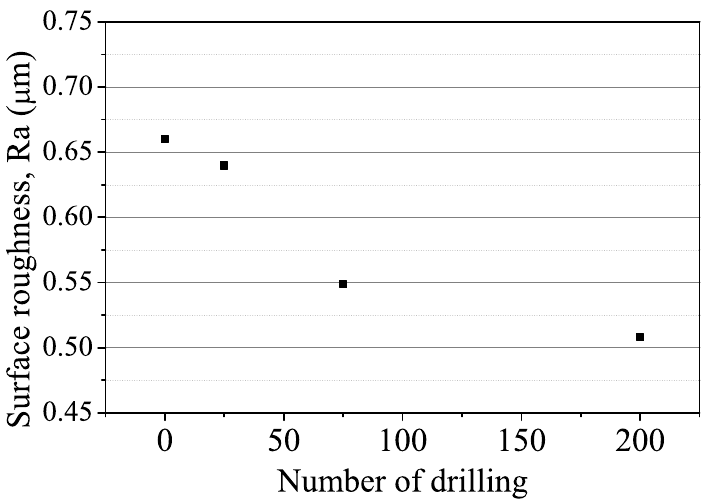
Figure 12. Surface roughnesses of tools according to the numbers of drilling (drilling conditions: axial feedrate 10 µ m/s; rotational speed pf 50,000 rpm; drilling depth of 200 µ